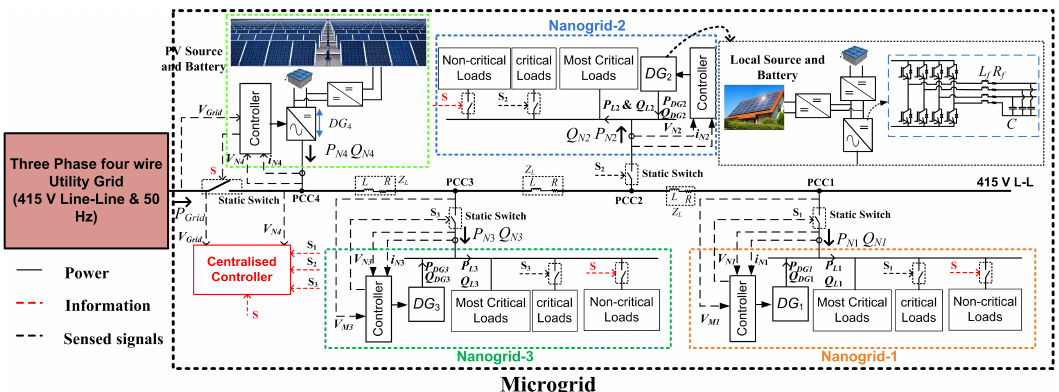
Figure 1. Schematic of proposed microgrid for residential